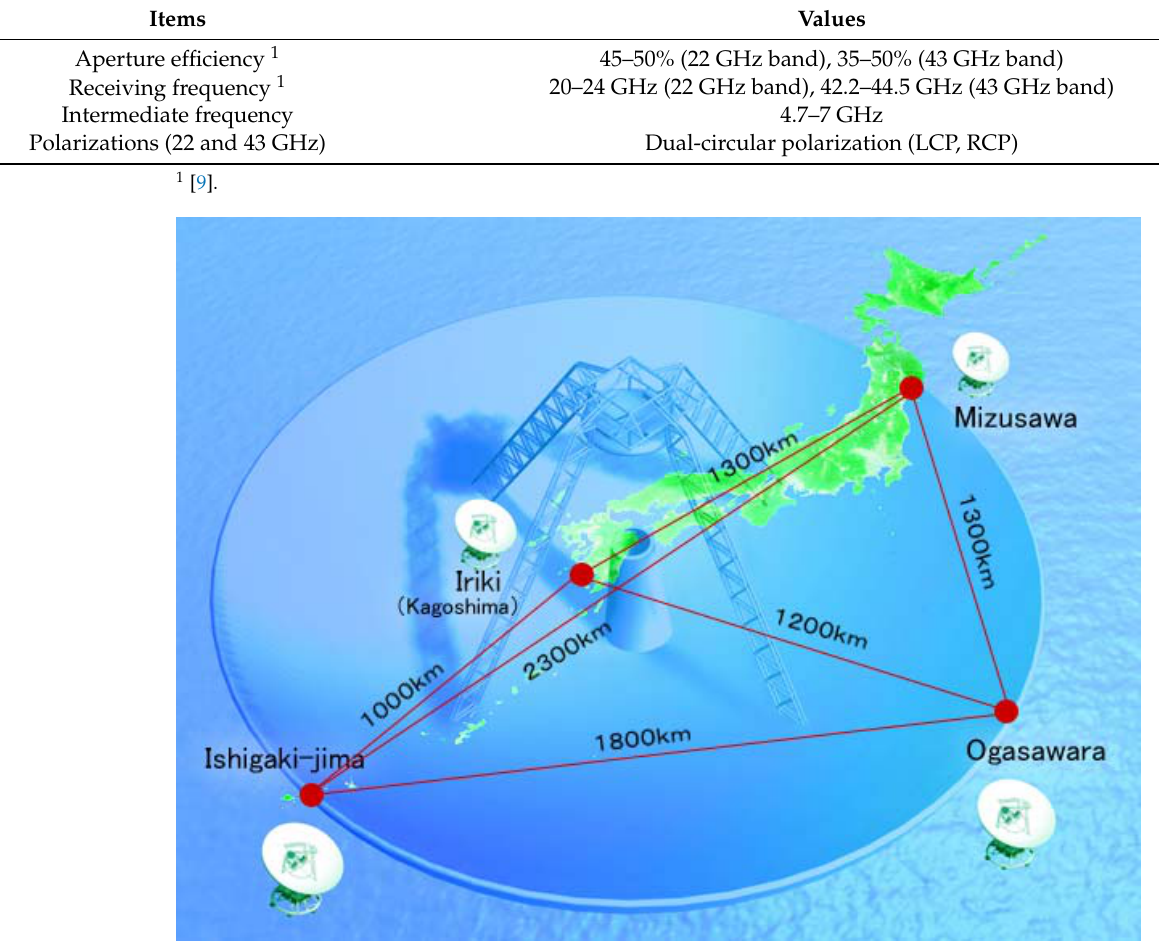
Figure 1. An overview of the VERA array, consisting of four telescopes located at Mizusawa, Iriki, Ogasawara, and Ishigaki-Jima (Image